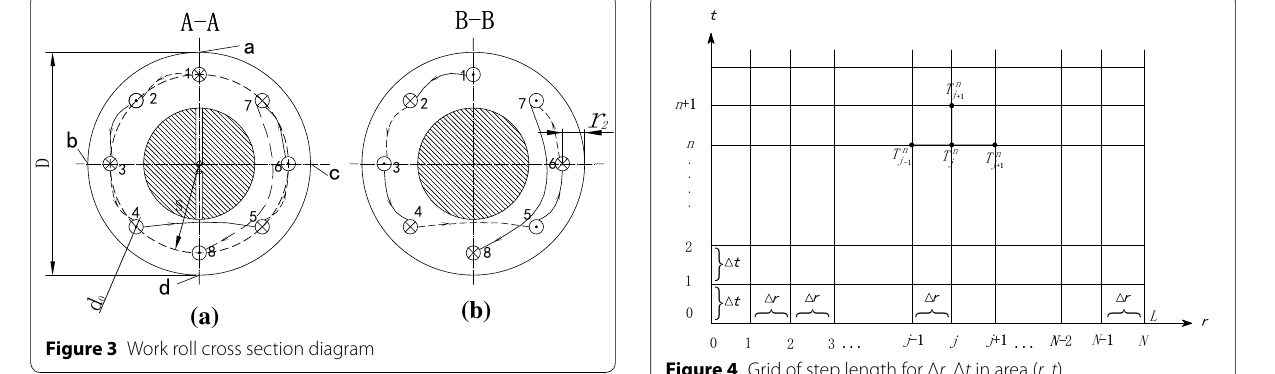
Figure 4 Grid of step length for Δ r , Δ t in area ( r , t